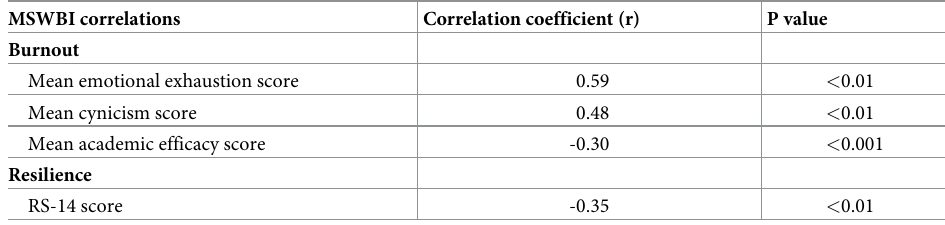
Table 5. Correlations between Medical Students Well-Being Index (MSWBI) and burnout and resilience